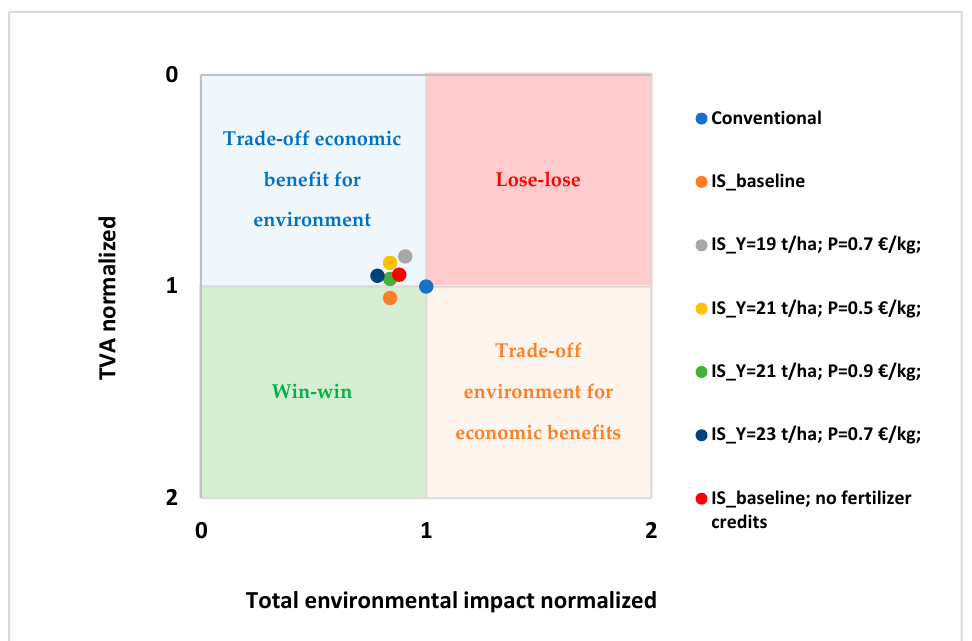
Figure 9. Two-dimensional eco-efficiency chart (TVA vs. environmental impact) showing the relative positioning of table grape production with the integrated system or IS (groundwater + reclaimed water) under different yield (Y) and market prices (P).